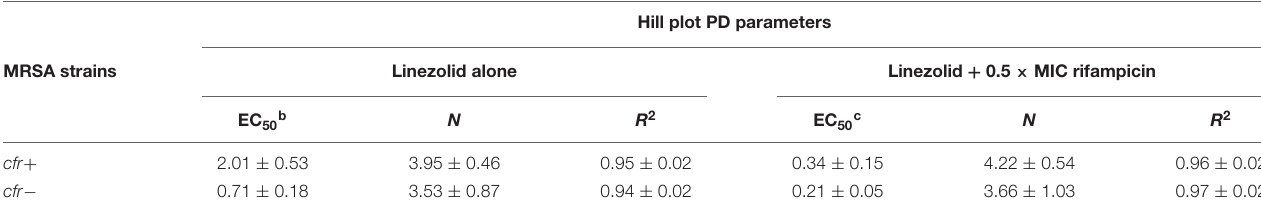
TABLE 2 | Calculated EC 50 and Hill slope ( N ) values representing the antimicrobial potency of linezolid alone or with 0.5 × MIC rifampicin against cfr -positive and -negative MRSA strains. a